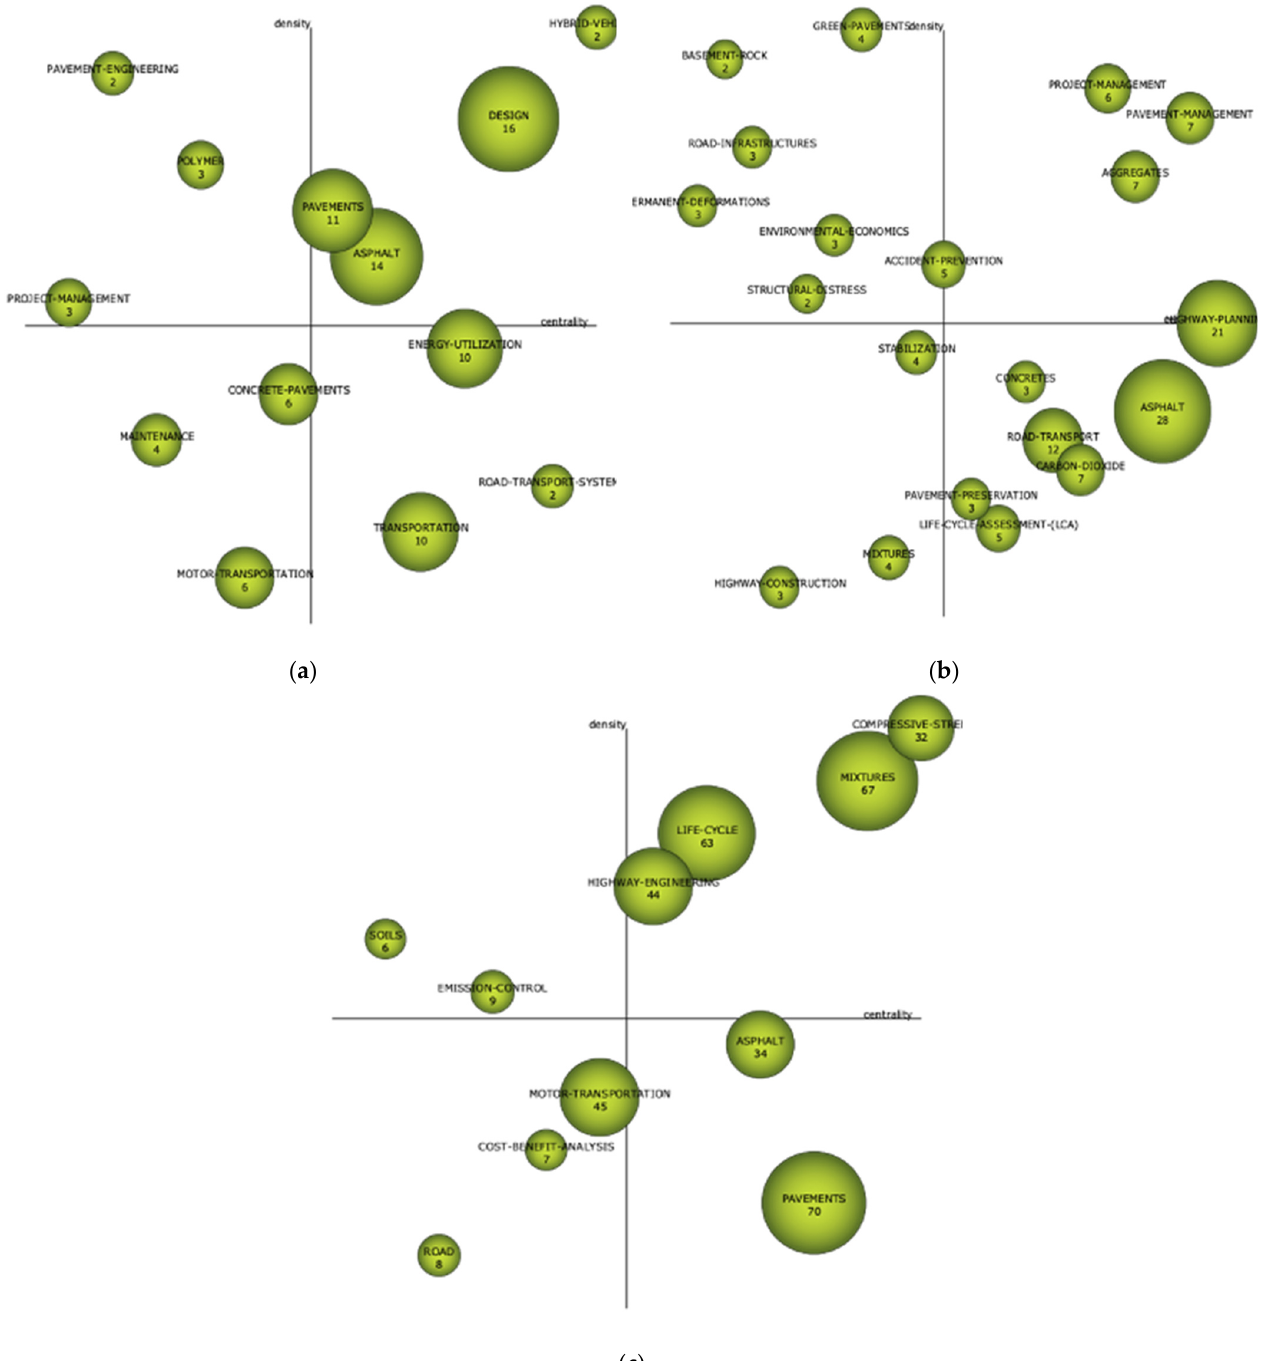
Figure 9. Strategic diagrams by number of documents for 1st, 2nd, and 3rd periods ( a , b , c ), respec-